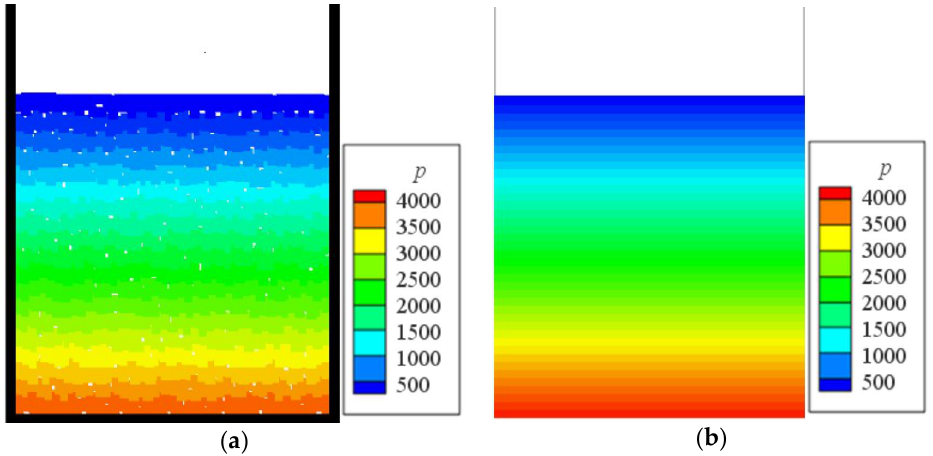
Figure 4. Comparison of the pressure field simulated by the ( a ) Pusan-National-University-modified moving particle simulation (PNU-MPS) and ( b ) present refined PNU-MPS adopting the staggered divergence-free model and the moving-particle wall boundary treatment after 3 s of simulations.